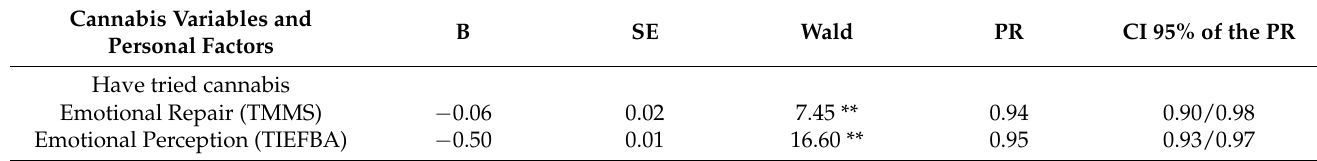
Table 4. Binomial regression analysis based on the 12–13 years age group.